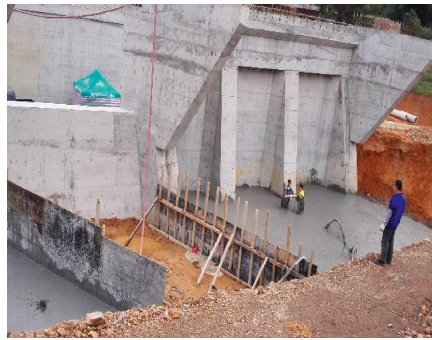
Figure 14: Schematic diagram of pouring.